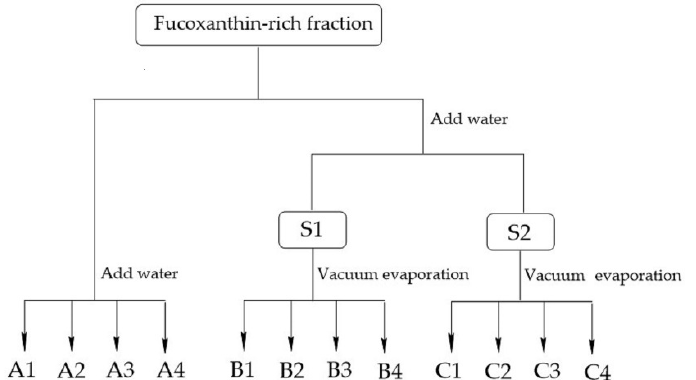
Figure 11. Optimization of the precipitation of FX. Solution S1 was prepared by adding water to 70% ethanol content, and solution S2 was prepared by adding water to 80% ethanol content. The solutions A1–A4 were prepared by adding water directly. The solutions B1–B4 and C1–C4 were prepared by vacuum evaporation at room temperature. The ethanol content in group 1 solutions (including A1, B1, and C1), group 2 solutions (including A2, B2, and C2), group 3 solutions (including A3, B3, and C3), and group 4 solutions (including A4, B4, and C4) was 30, 40, 50, and 60%, respectively. All operations were performed at room temperature.